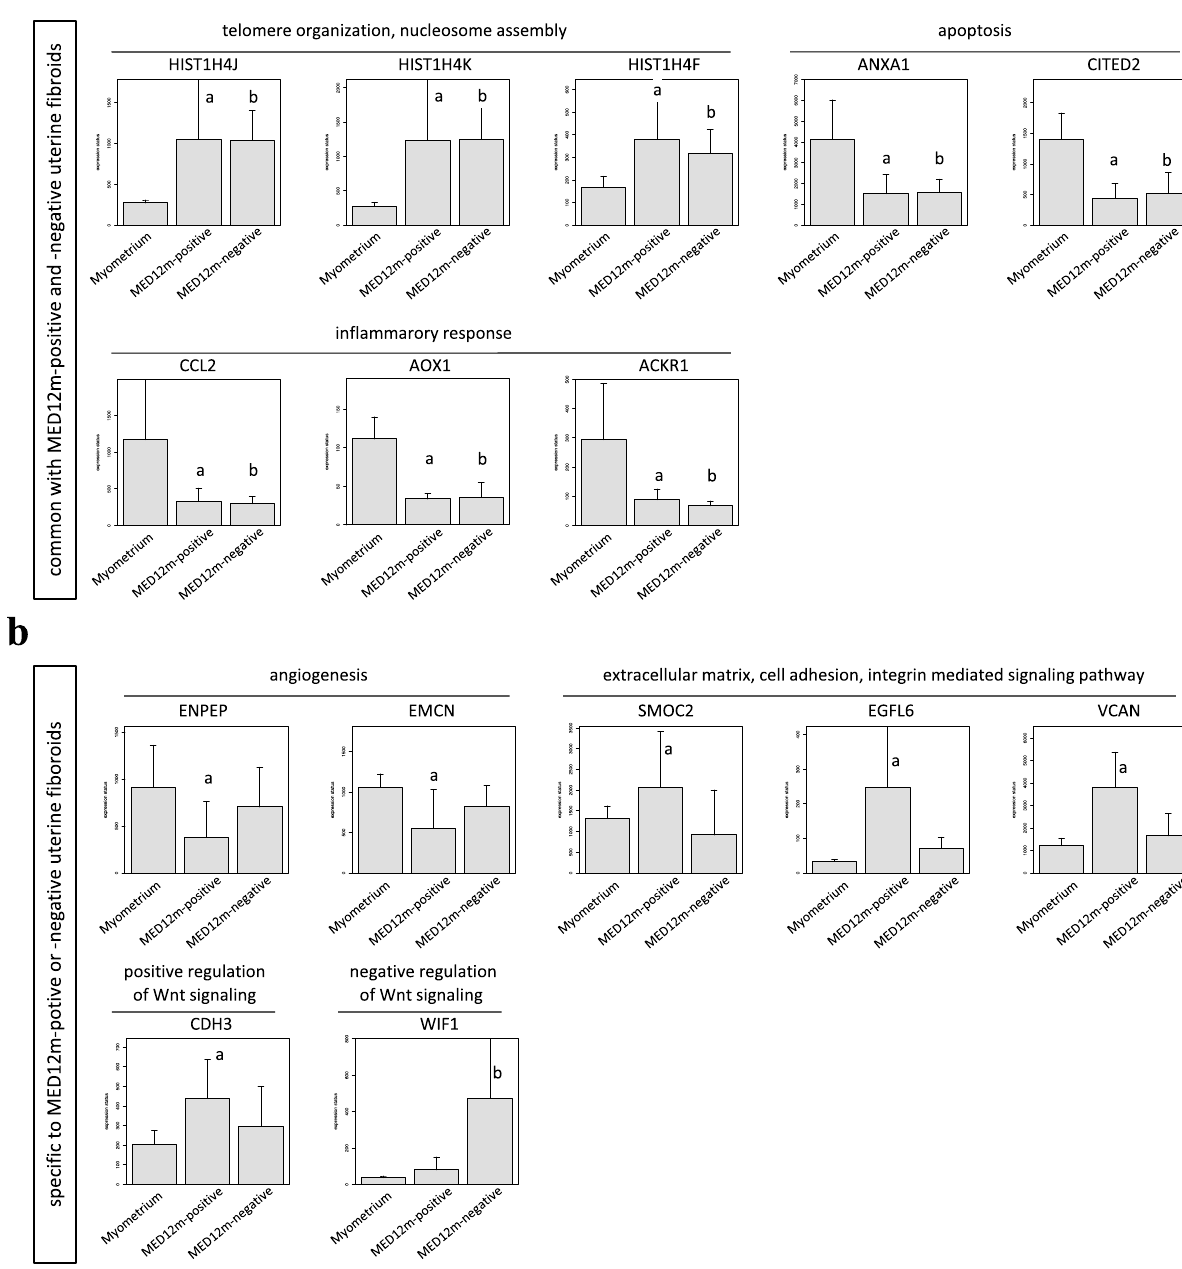
Figure 3. Expression levels of representative genes in the detected biophysical processes. According to Figs. 2e, Fig. 3 shows the expression statuses of the representative genes not only from the commonly detected terms between the MED12m-positive and MED12m-negative uterine fibroids ( a ), but also from the terms specific to the MED12m-positive or the MED12m-negative uterine fibroids ( b ). We selected the genes in which the difference in expression levels was clearly significant among the MED12m-positive uterine fibroids, the MED12m-negative uterine fibroids, and the normal myometrium. a p < 0.01 (myometrium (n = 6) vs. MED12m- positive uterine fibroids (n = 6), student t-test). b p < 0.01 (myometrium (n = 6) vs. MED12m-negative uterine fibroids (n = 9), student